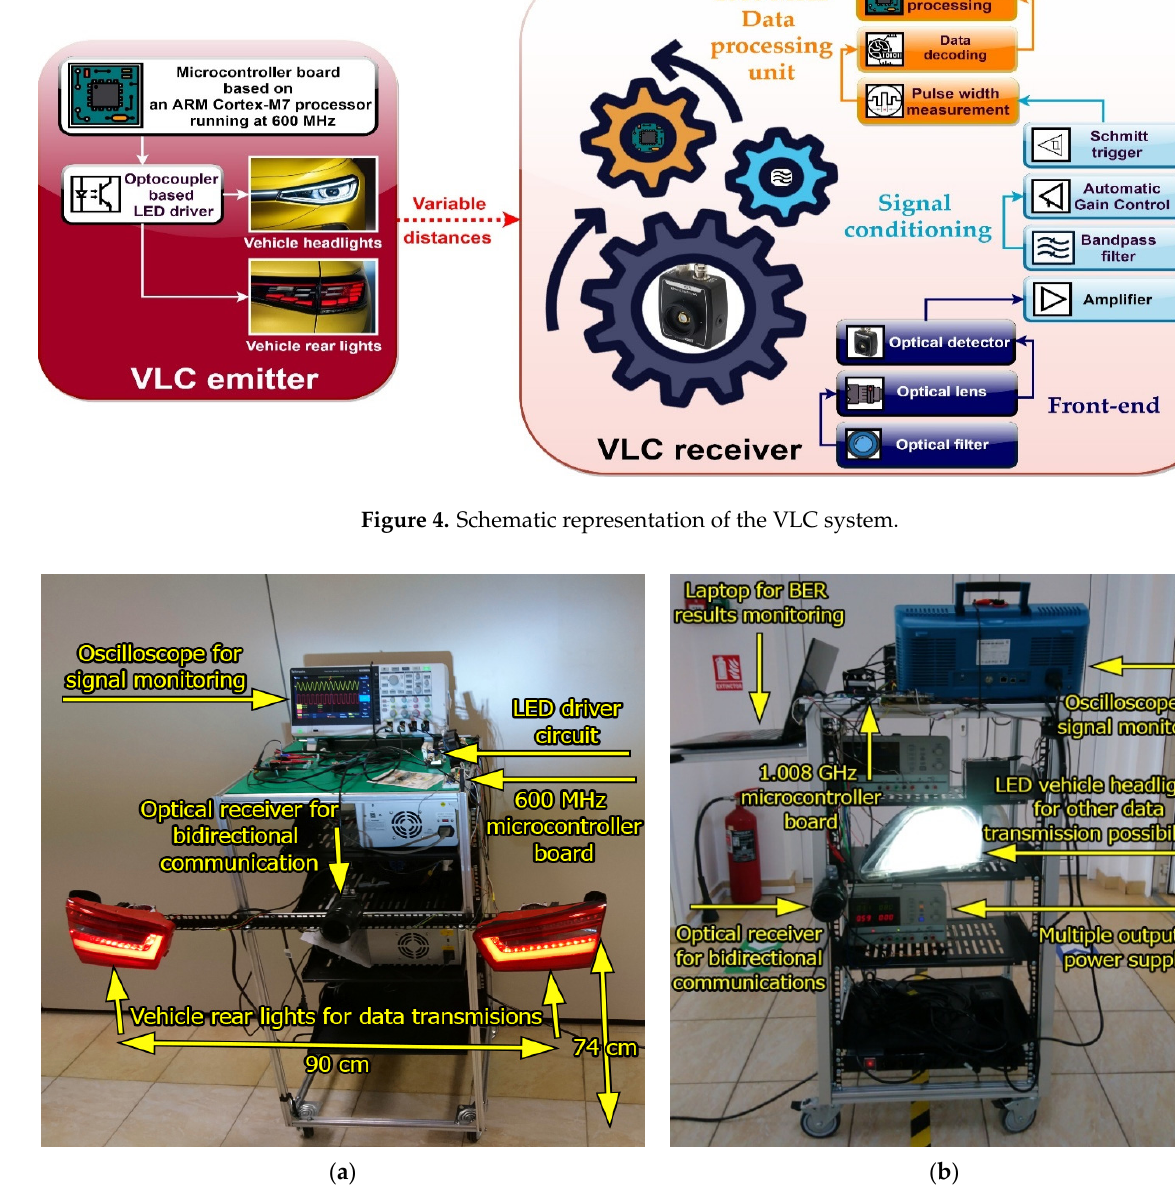
Figure 5. Hardware implementation of the visible light communication prototype for light dimming: ( a ) Emitter; ( b ) Receiver.